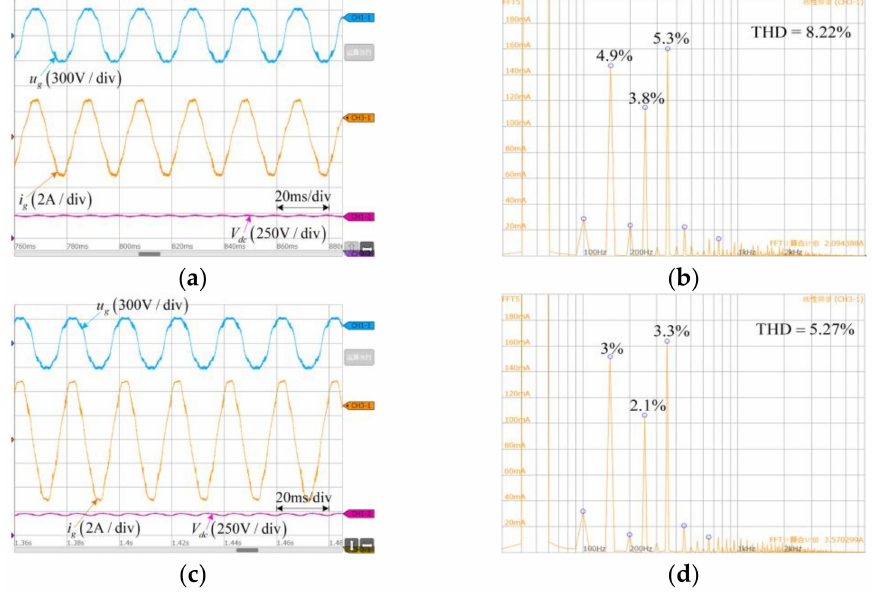
Figure 16. Experimental waveforms of Q1S AC-DC converter driven by ITPS. ( a , b ) Im is 3A, ( c , d ) Im is